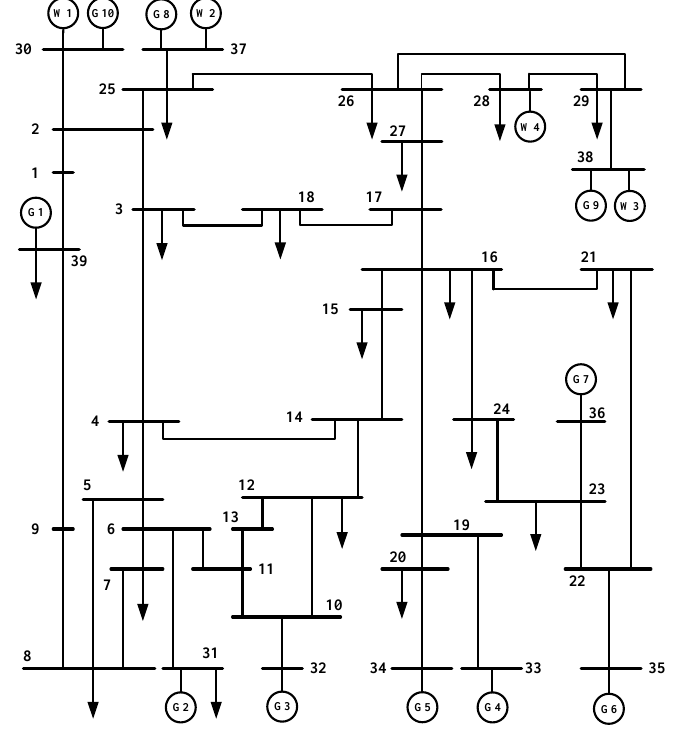
Figure 4. Modified IEEE-39 bus system. Table 1. Parameters of the thermal units.